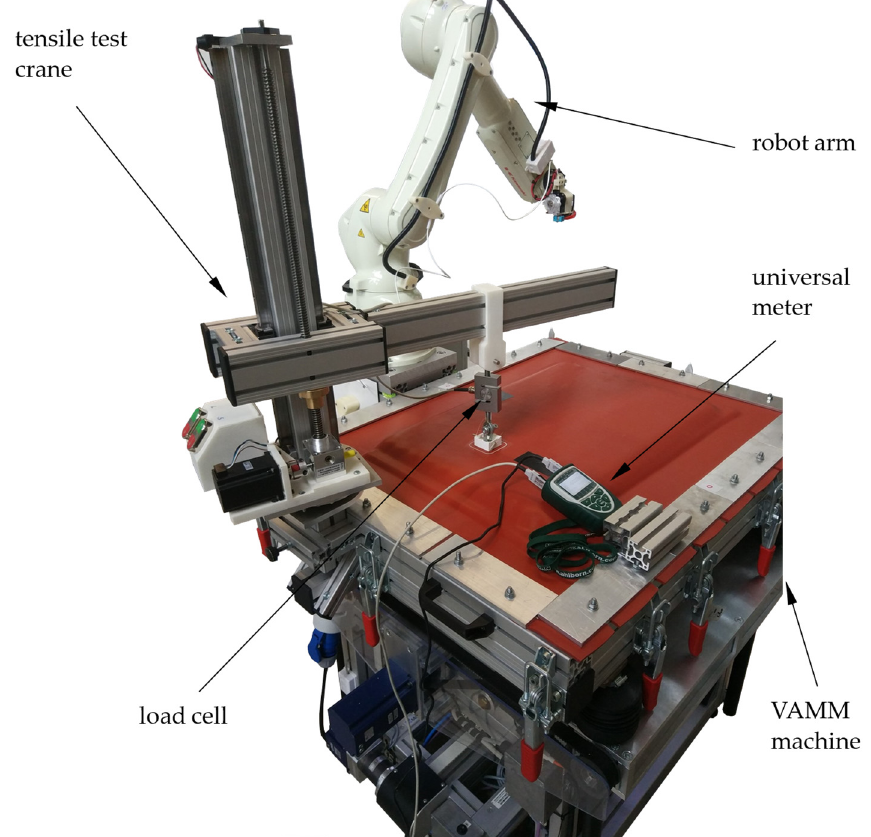
Figure 4. EMMA test rig with the setup for the adhesion test.